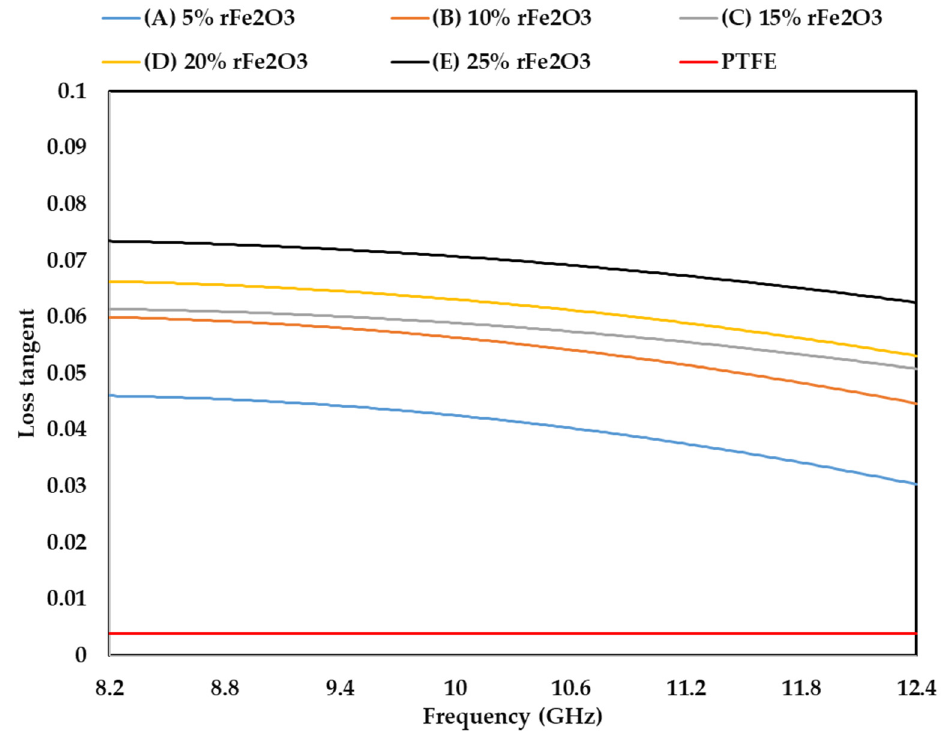
Figure 13. Variation in loss tangent of rFe 2 O 3 –PTFE nanocomposites.